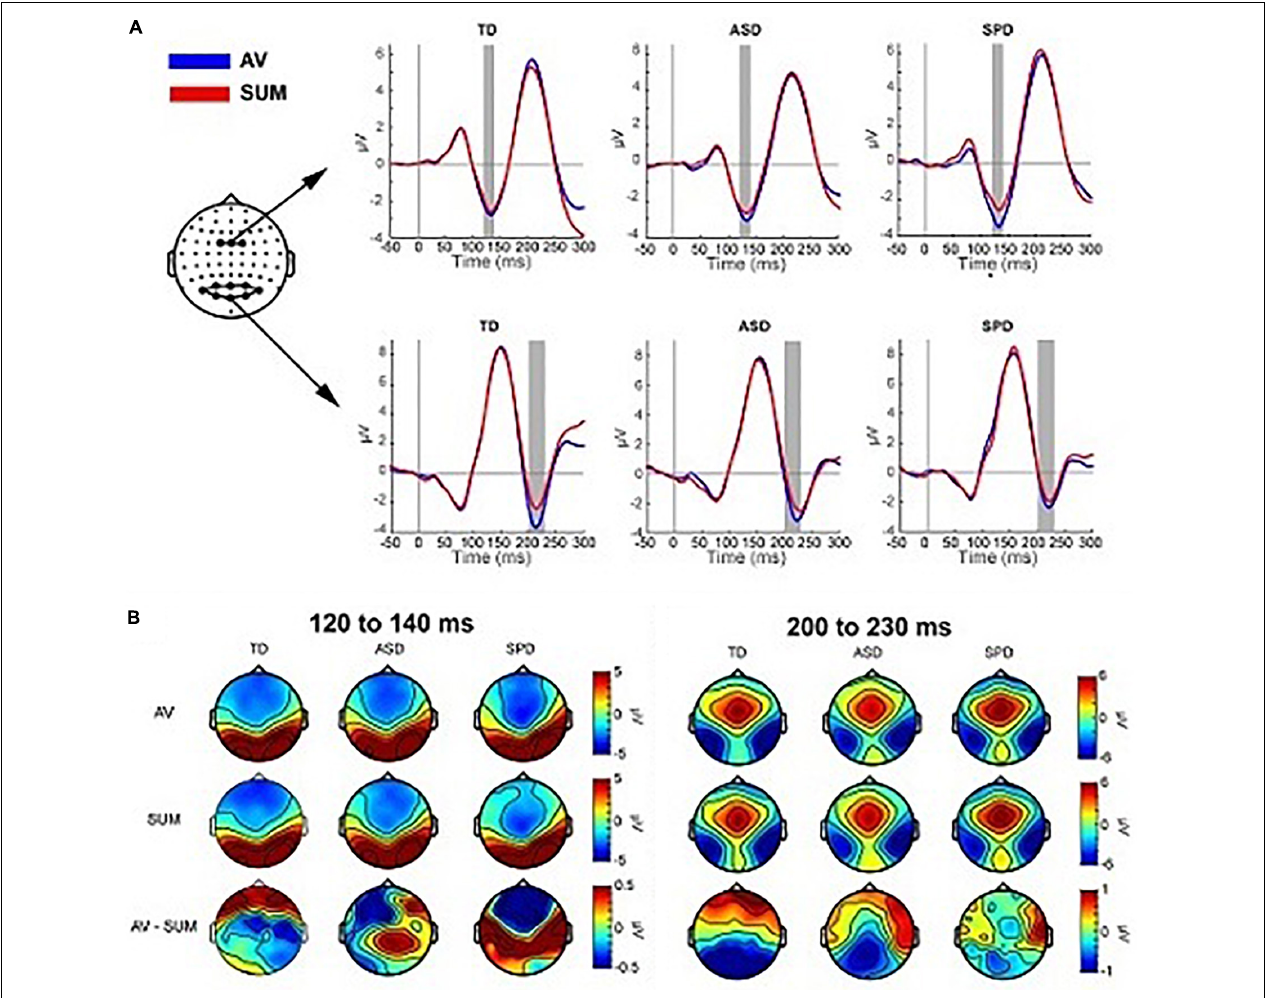
FIGURE 5 | Multisensory effects. (A) Grand average waveforms for the AV and SUM conditions averaged over the two clusters of electrodes used in the planned comparisons. The gray rectangles indicate the time range used to compute the average amplitude in the analyses. (B) Topographies averaged over the two time windows depicted in panel (A) . The top row shows the topographic distribution in the AV condition, the middle row shows the SUM condition and the bottom row depicts their difference (AV minus